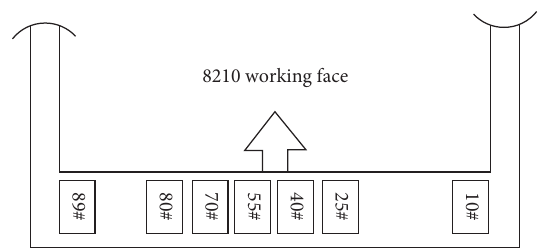
Figure 14: The face pressure observation station layout of No. 8210 working face in large fully mechanized mining